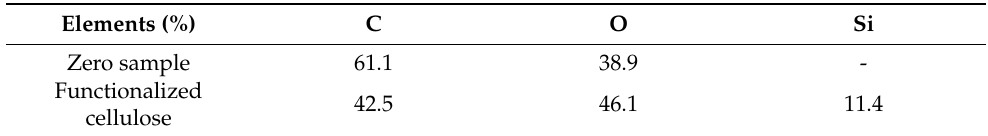
Table 2. The relative mass fraction of detected elements in the zero sample and in the functional- ized